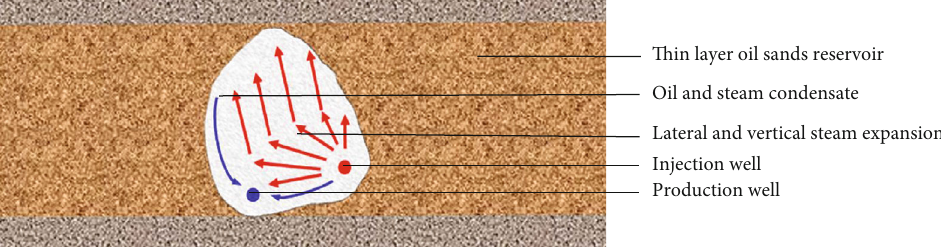
Figure 2: The SAGD concept of changing horizontal position between two wells.